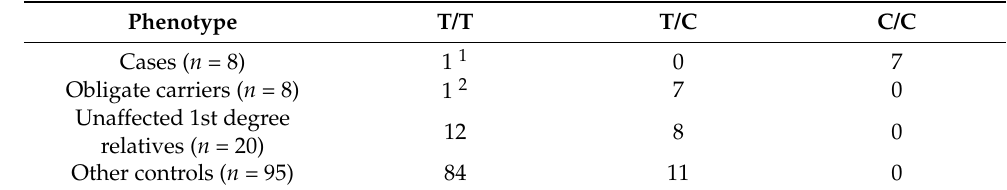
Table 2. Association of the genotypes at the PCYT1A :c.673T>C variant with disproportionate dwarfism in the studied Vizslas.